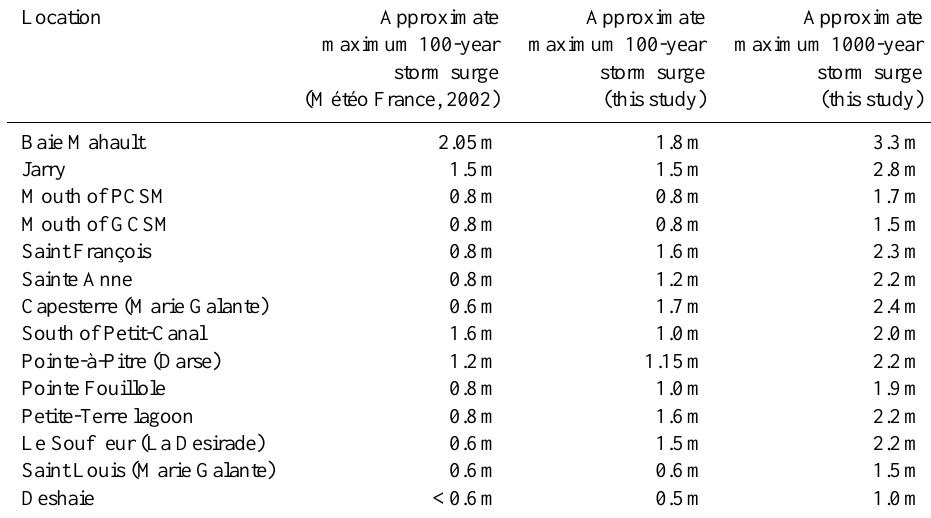
Table 3. Comparison of maximum 100- and 1000-year storm surges for this study and the early models of Météo France (2002) (see Fig. 2 for